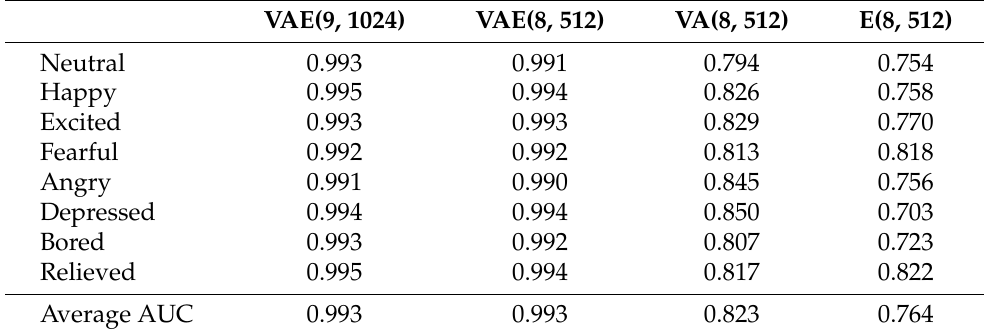
Table 7. AUC result of the proposed SFER